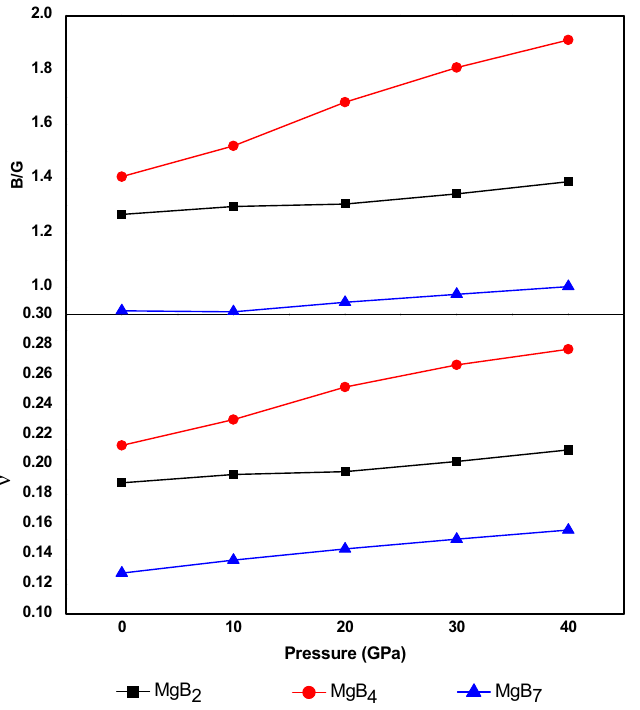
Figure 6. Pressures dependence of the B/G ratio and Poisson’s ratio ʋ